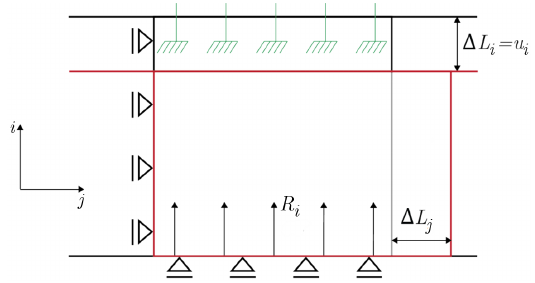
Figure 13. 2D representation of the SID boundary